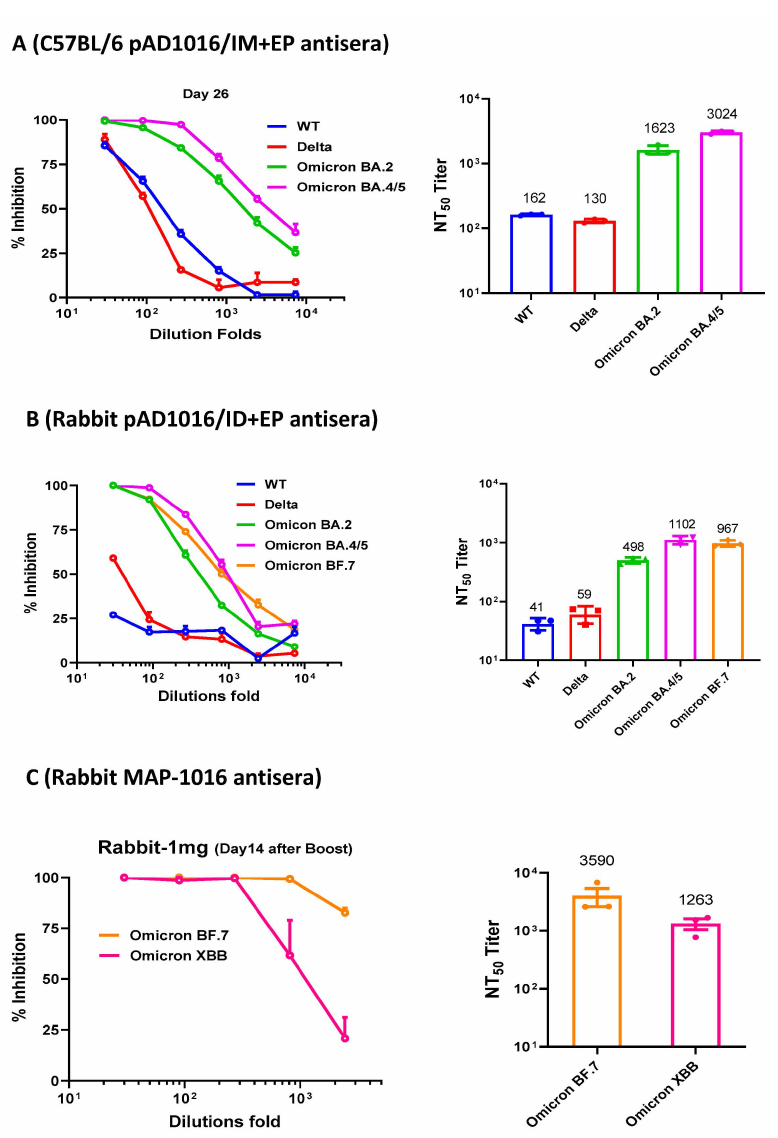
Figure 3. Neutralization antibodies induced by pAD1016 in mice and rabbits. ( A ) C57BL/6 mice ( n = 5) were administered with 2 doses (20 µ g/dose, fortnight interval) of pAD1016/IM+EP followed by serum sample collection 14 days after boost. An equal proportion mixture of the serum samples was tested for ability to block mimic infection of ACE2-expressing HEK293T cells by pseudoviruses displaying S protein of SARS-CoV-2 WT, Delta, Omicron BA.2 or BA.4/5 variants. ( B ) Rabbits ( n = 3) administered with 2 doses (500 µ g/dose, fortnight interval) of pAD1016/IM+EP followed by serum sample collection 14 days after boost immunization. An equal proportion mixture of the serum samples was tested for ability to block mimic infection of ACE2-expressing HEK293T cells by pseudoviruses displaying S protein of SARS-CoV-2 WT, Delta, Omicron BA.2, BA.4/5 or BF.7. ( C ) A serum sample from rabbits (equal proportion mixture of 3 rabbits) 14 days after 2 doses of MAP-1016 immunization (500 µ g/MAP/dose, fortnight interval) was assayed for ability to block mimic infection of ACE2-expressing HEK293T cells by pseudoviruses displaying S protein of SARS-CoV-2 Omicron BA.7 or XBB. The results are expressed as percent inhibition of infection (left panels) and NT50 titers (right panels). Data are means ±